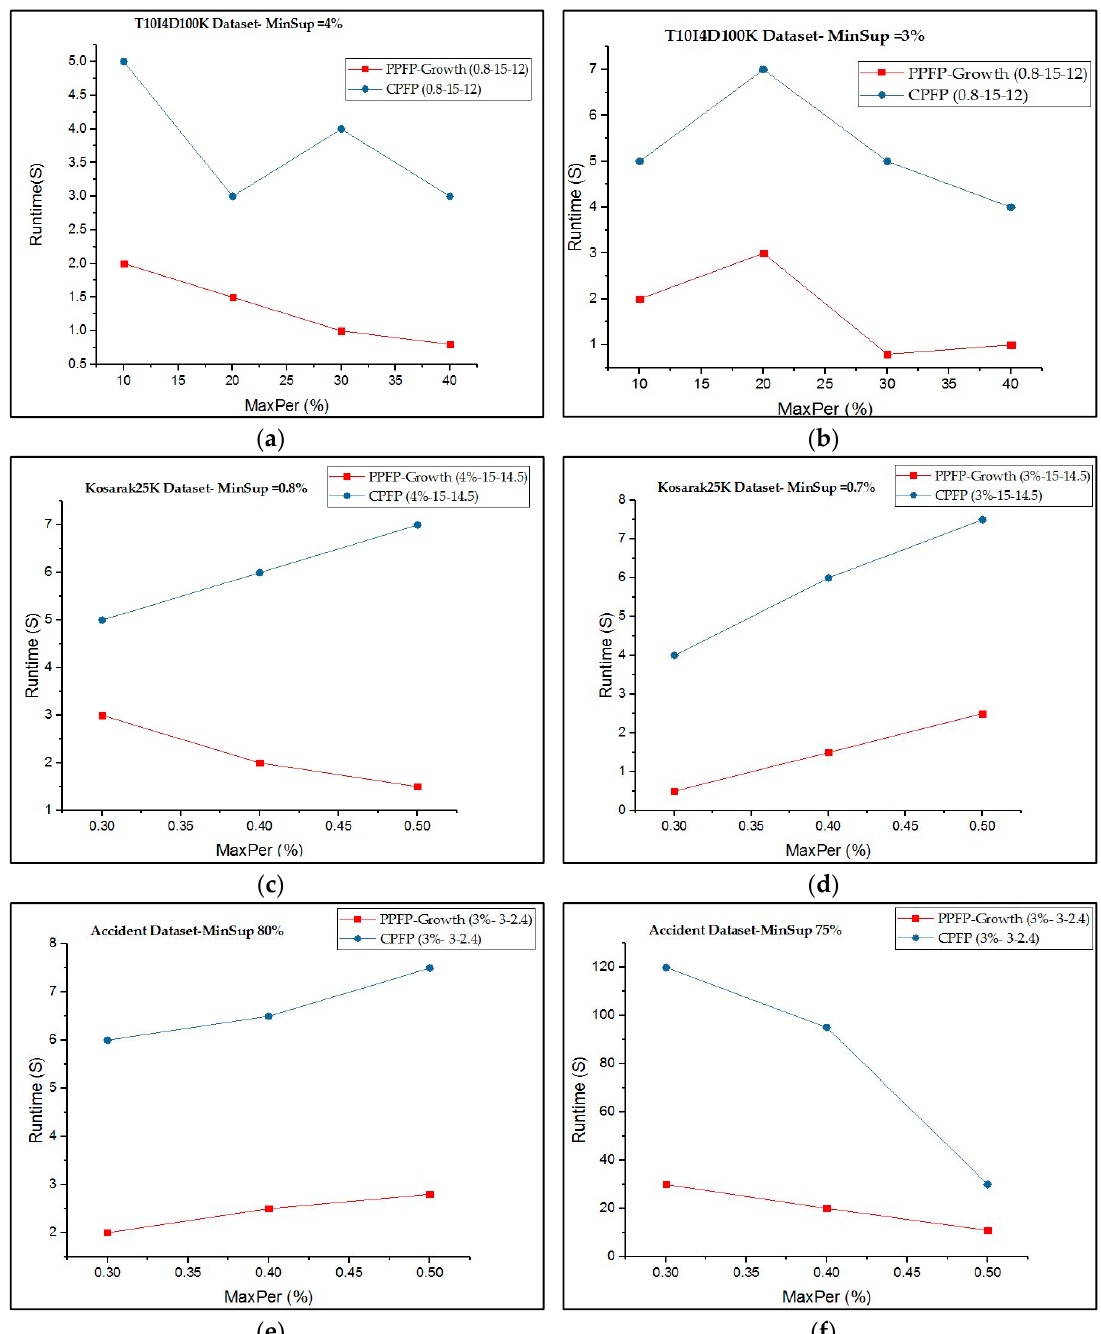
Figure 4. Execution times of PPFP-growth and CPFP. ( a ) Execution time on T10I4D100K with MinSup = 4%. ( b ) Execution time on T10I4D100K with MinSup = 3%. ( c ) Execution time on Kosarak25K with MinSup = 0.8%. ( d ) Execution time on Kosarak25K with MinSup = 0.7%. ( e ) Execution time on accident with MinSup = 80%. ( e ) Execution time on accident with MinSup = 75%.